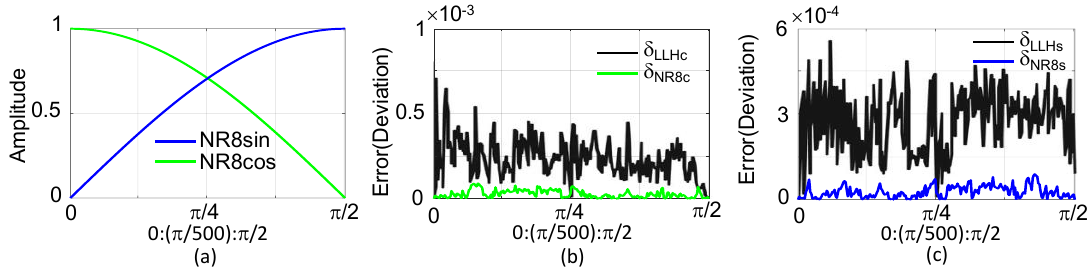
Figure 5. ( a ) The curves of cosine and sine computed by the NR-8 CORDIC algorithm. ( b ) Comparison of errors for cosine between the NR-8 and the LLH CORDIC with 16-bit precision. ( c ) Comparison of errors for sine between the NR-8 and the LLH CORDIC with 16-bit precision.